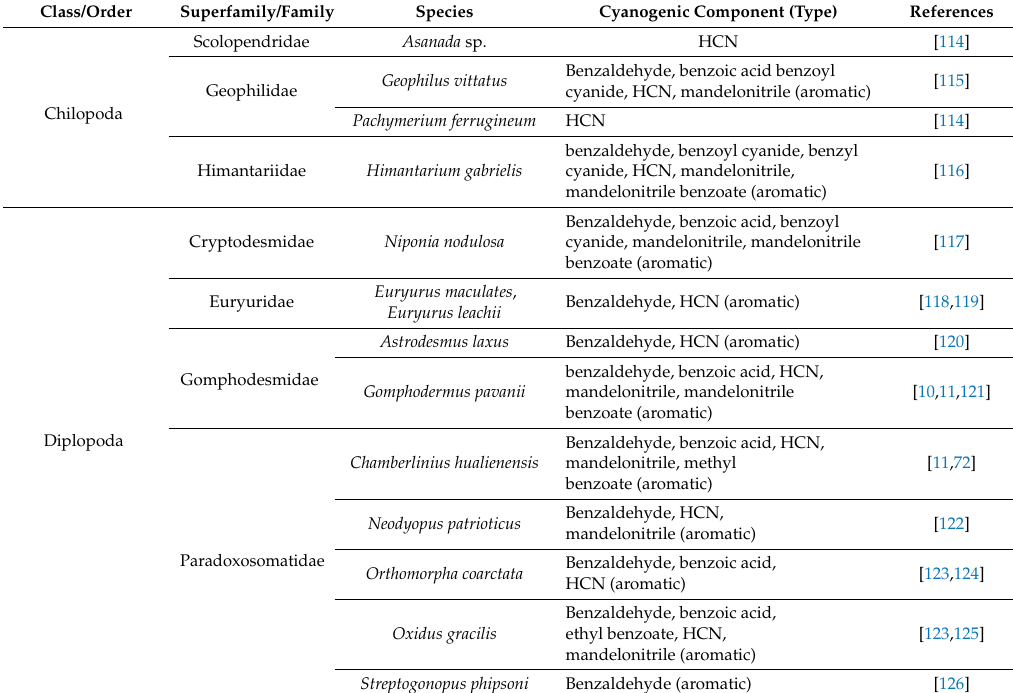
Figure 7. Cyanogenic compounds or derivatives thereof discussed in this paper sorted into the aliphatic, aromatic or cyclopentenoid groups of CNglcs or a group of other cyanogenic compounds. Table 1. Cyanogenesis in Arthropoda.